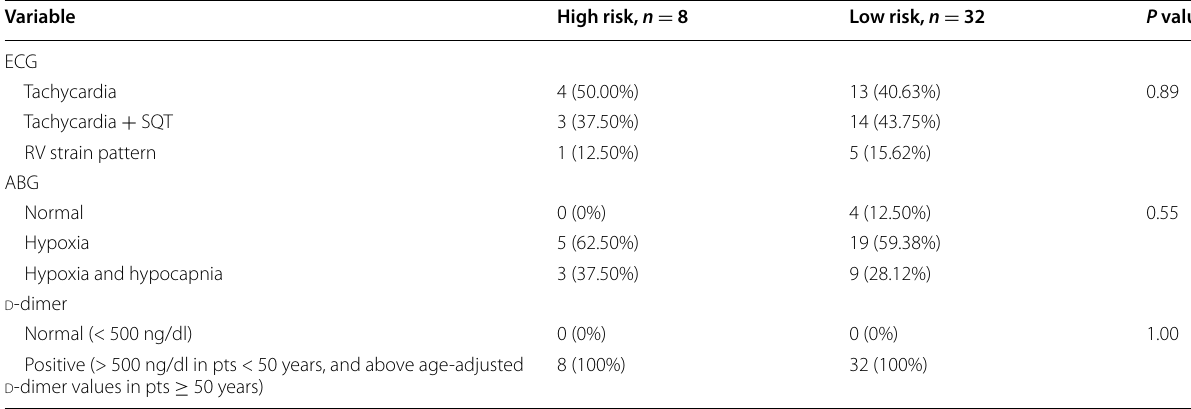
Table 3 Relation between the presence of risk stratification of PTE and different investigations